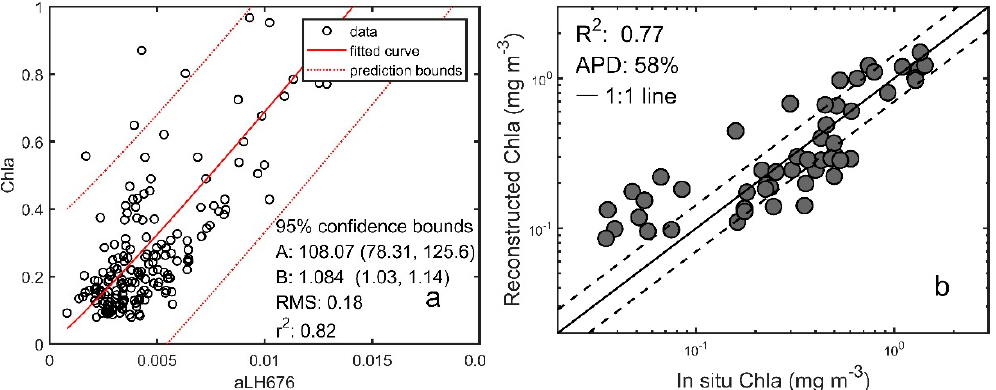
Figure 10. ( a ) Fitted curve and scatter plots between a LH (676) and Chla of NESCS dataset. ( b ) Scatter